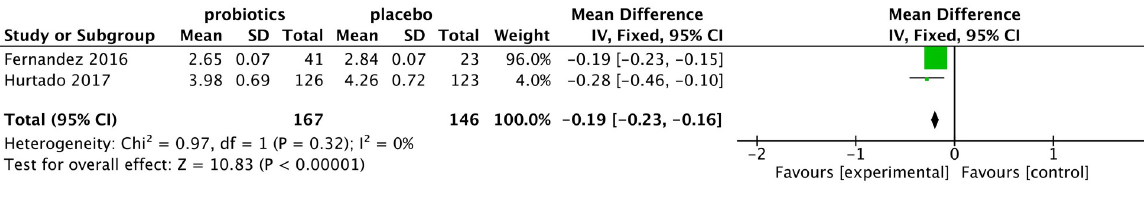
Fig 7. Forest plot of bacterial counts in healthy